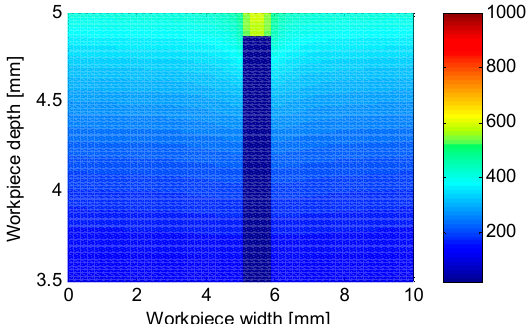
Figure 4. Temperature distribution in a section of the workpiece at the maximum temperature on the cavity bottom.